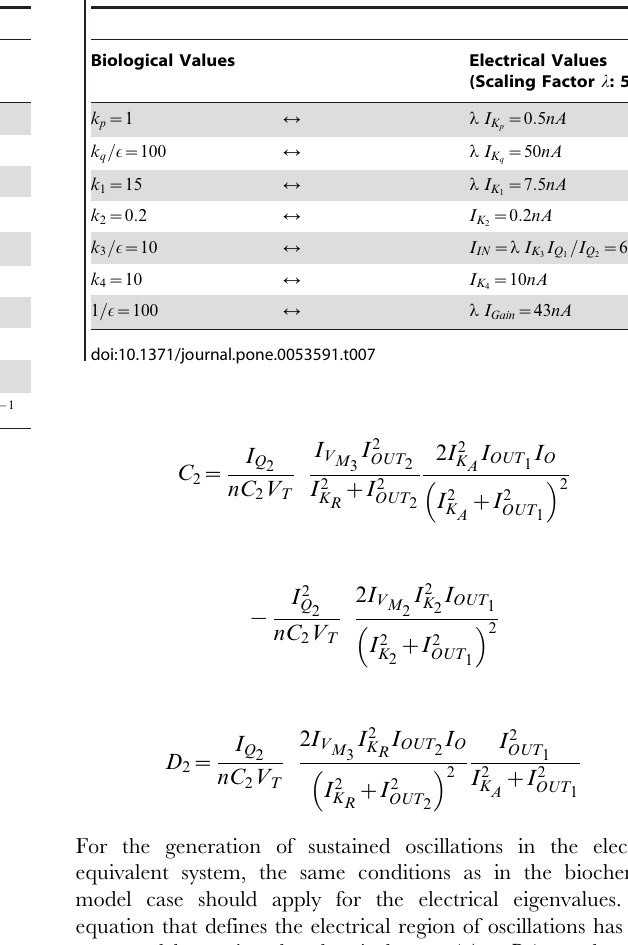
Table 5. Biological And Electrical Values For The Ca 2 z Oscillations Model ( m ~ n ~ p ~ 2 Case).